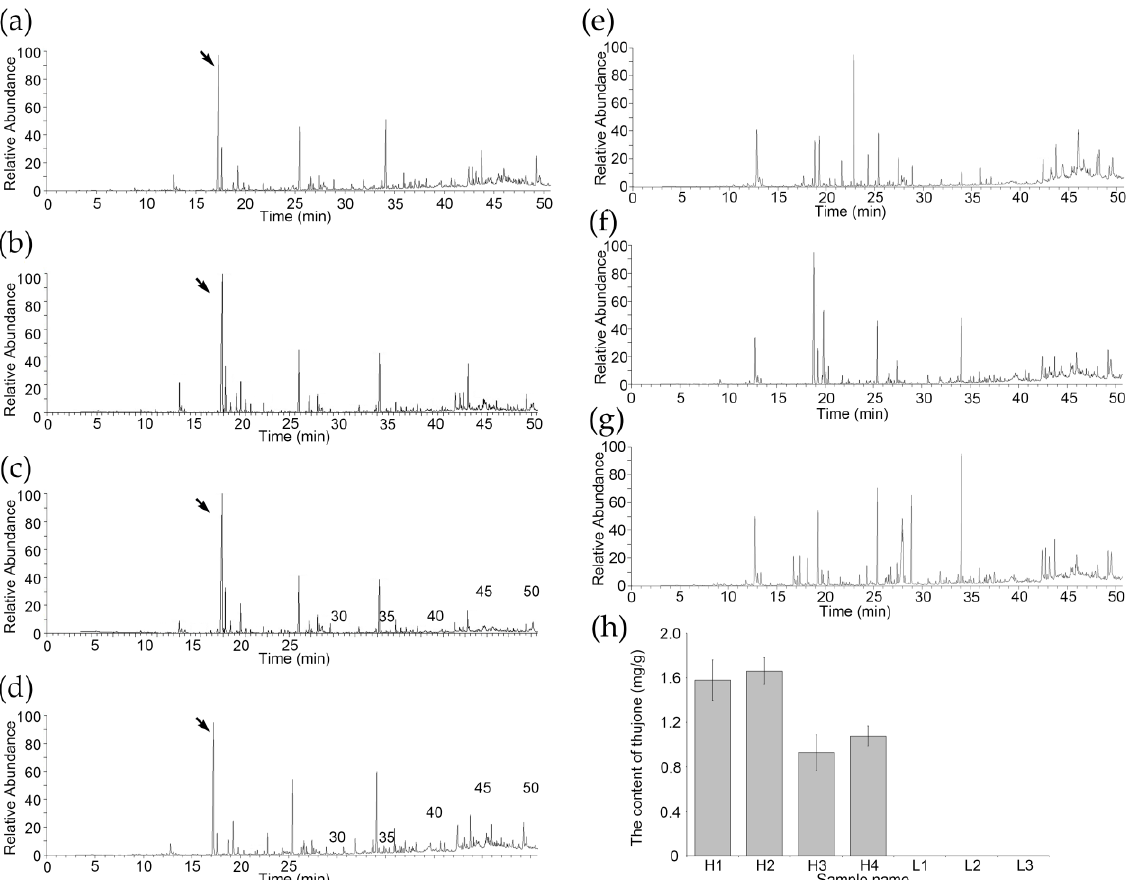
Figure 1. Gas chromatogram and the thujone content in high and low thujone-producing materials. ( a – g ) Gas chromatogram of H1 ( a ), H2 ( b ), H3 ( c ), H4 ( d ), L1 ( e ), L2 ( f ), and L3 ( g ). The arrows indicate the peak of thujone. ( h ) The thujone content in seven high and low thujone-producing A. argyi varieties. H1, H2, H3, and H4 indicate four varieties with high thujone content. L1, L2, and L3 indicate three varieties with low thujone content.